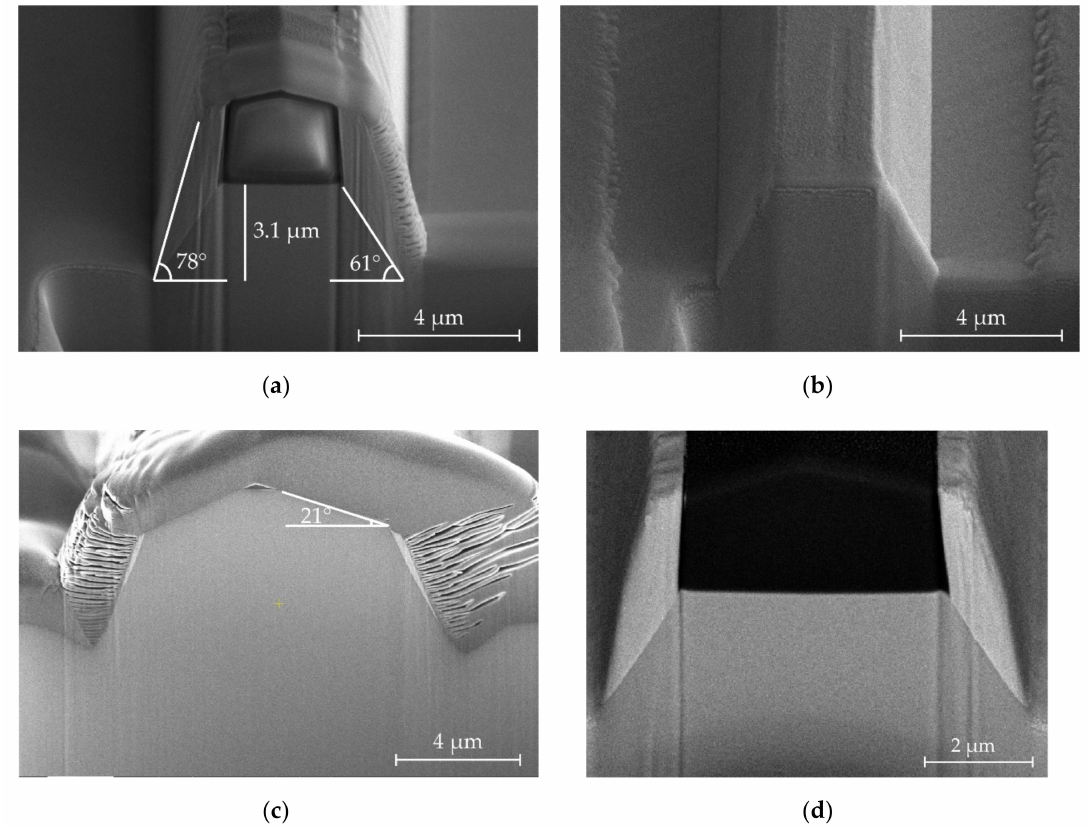
Figure 6. Focusedionbeam(FIB)cross-sectionsofetchedstructuresatvariouspointsduringtheprocessing. ( a ) A KY(WO 4 ) 2 immediately after dry etching. Significant redeposited ears extend above the structure, to the total height of the remaining SiO 2 mask. The horizontal width of the redeposited material is 1 µ m. A FIB-deposited Pt layer covers the cross-section to reduce geometric scanning electron microscope (SEM) artifacts and rounding during cross-sectioning. A sidewall angle of ~61 ◦ was measured for the KY(WO 4 ) 2 sidewall while the outer redeposition exhibits an angle of 78 ◦ . ( b ) A similar structure from the same batch after HCl etching and HF SiO 2 hard mask stripping. ( c ) SEM image of a similar structure, etched to a depth of 6.5 µ m. The SiO 2 hard mask was completely consumed, which led to the second angle (21 ◦ ) on the upper part of the sidewall. A thicker Pt layer has been used during the cross-sectioning. ( d ) FIB cross-section of a structure with significant redeposition imaged only using backscattered electrons. The redeposited material appears bright, indicating a higher concentration of heavy ions. In contrast, the SiO 2 mask, which is composed of light atoms, appears very